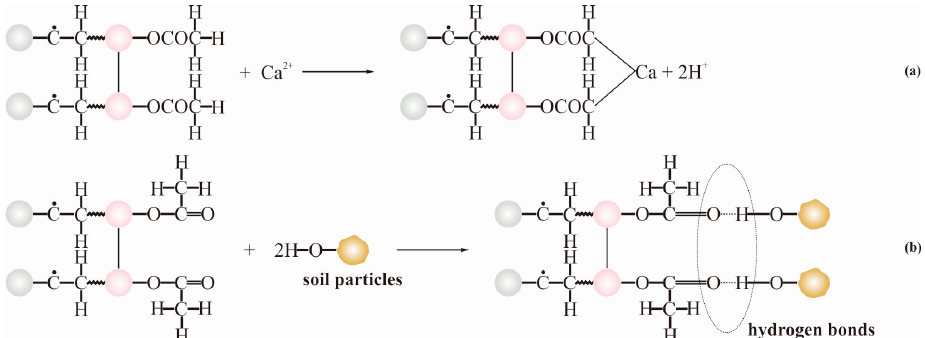
Figure 7. The reaction mechanism of the soil particles and the PVAc emulsion: ( a ) the displacement reaction of alkaline metal ions; ( b ) the reaction of hydrogen bonds formation.